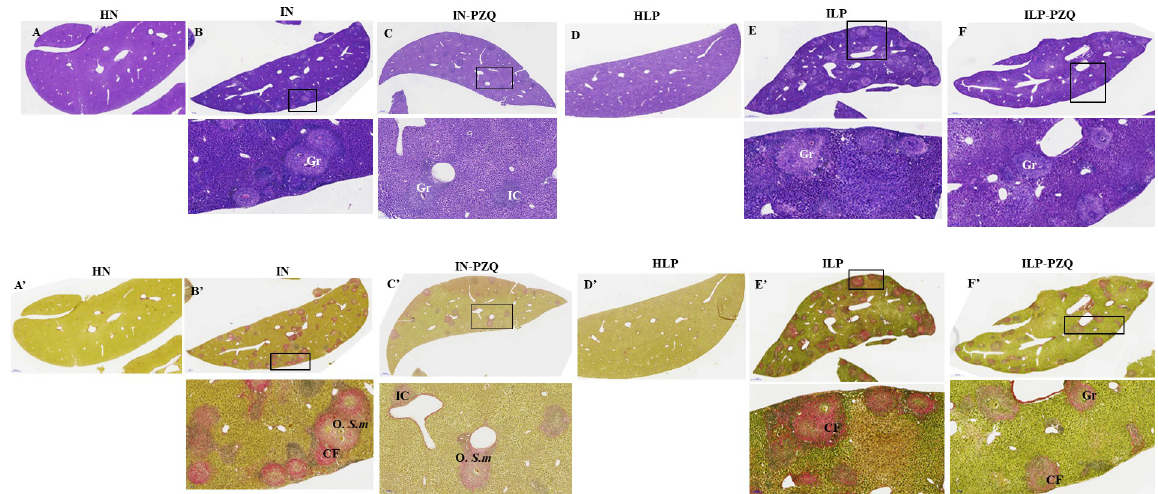
Fig 10. Effects of praziquantel treatment on the liver histology of Schistosoma mansoni -infected mice receiving a low-protein diet. A, B, C, D E, and F: Hematoxylin-eosin staining A’, B’, C’, D’, E’ and F’: Picrosirius staining. Group IN: infected-untreated mice receiving a standard diet; group IN-PZQ: infected mice receiving a standard diet and treated with praziquantel; group ILP: infected-untreated mice receiving a low- protein diet; group ILP-PZQ: infected mice receiving a low-protein diet and treated with praziquantel. IC: inflammatory cells, Gr: granuloma,